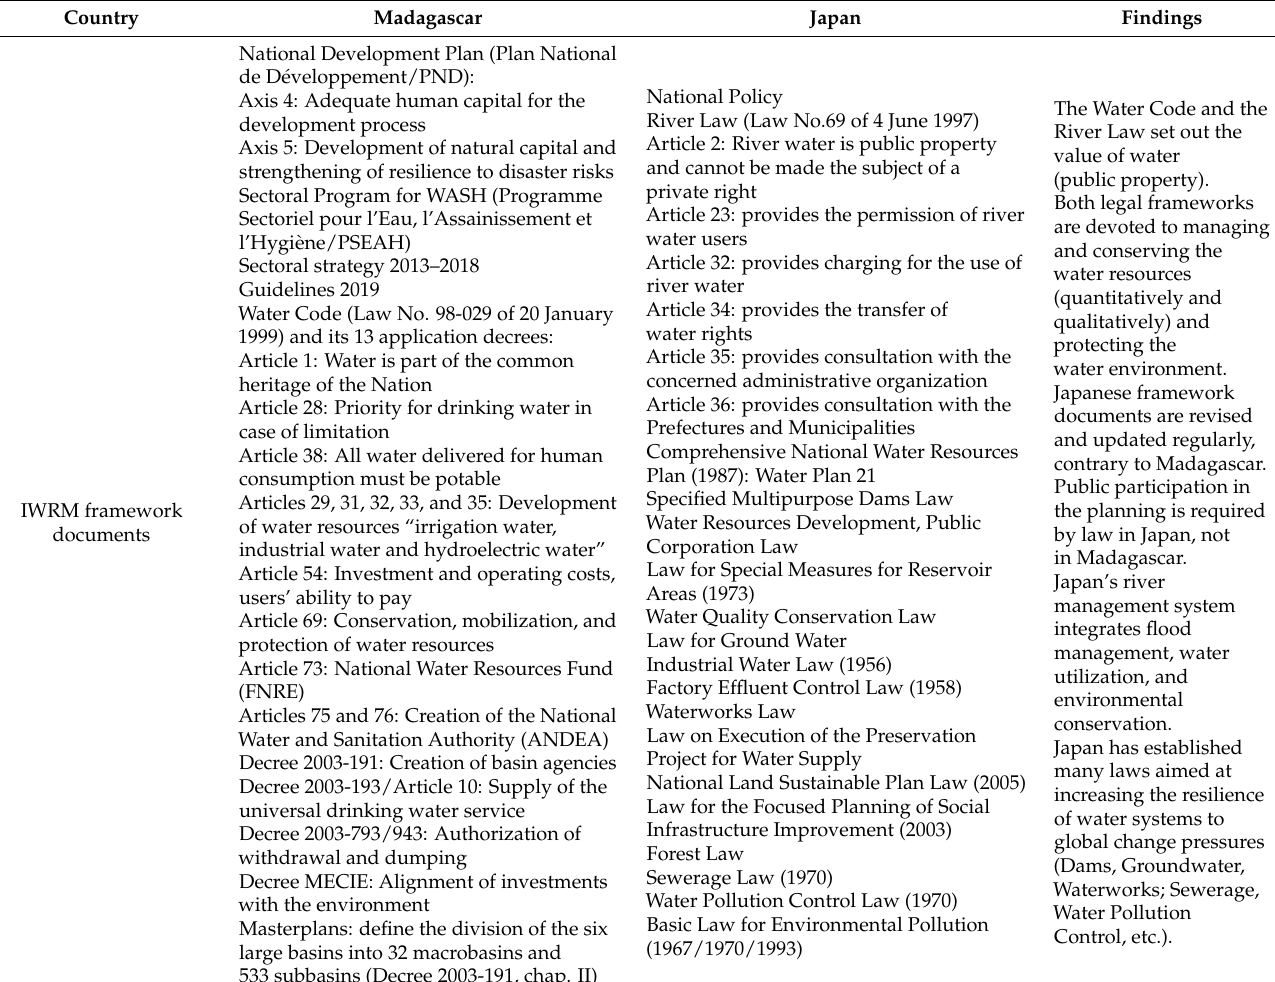
Table 1. Difference between IWRM framework documents in Madagascar and Japan.